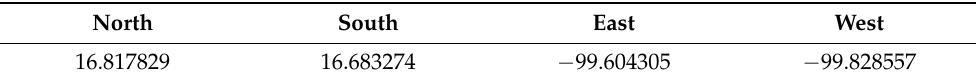
Figure 2. The Integrated Procedure for Estimate Sea Level Impacts (IPESLI), applied to estimate the effects of sea level rise in coastal areas. Table 1. Geographical boundaries of the study